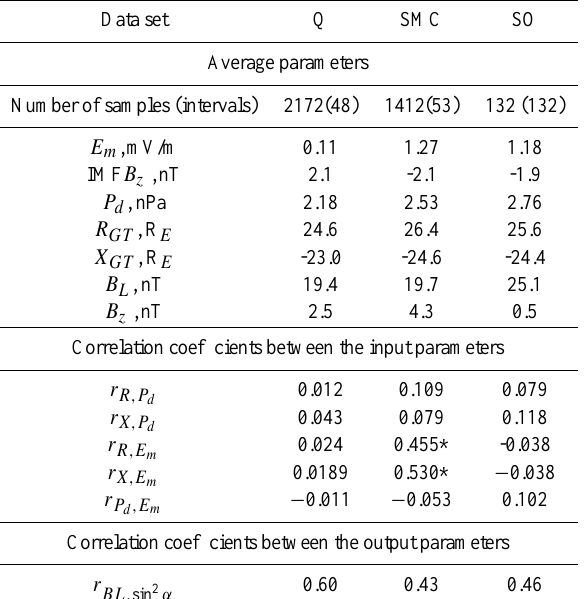
Table 1. Characteristics of different magnetospheric states. Table 2. Regression and correlation coefficients obtained from the regression